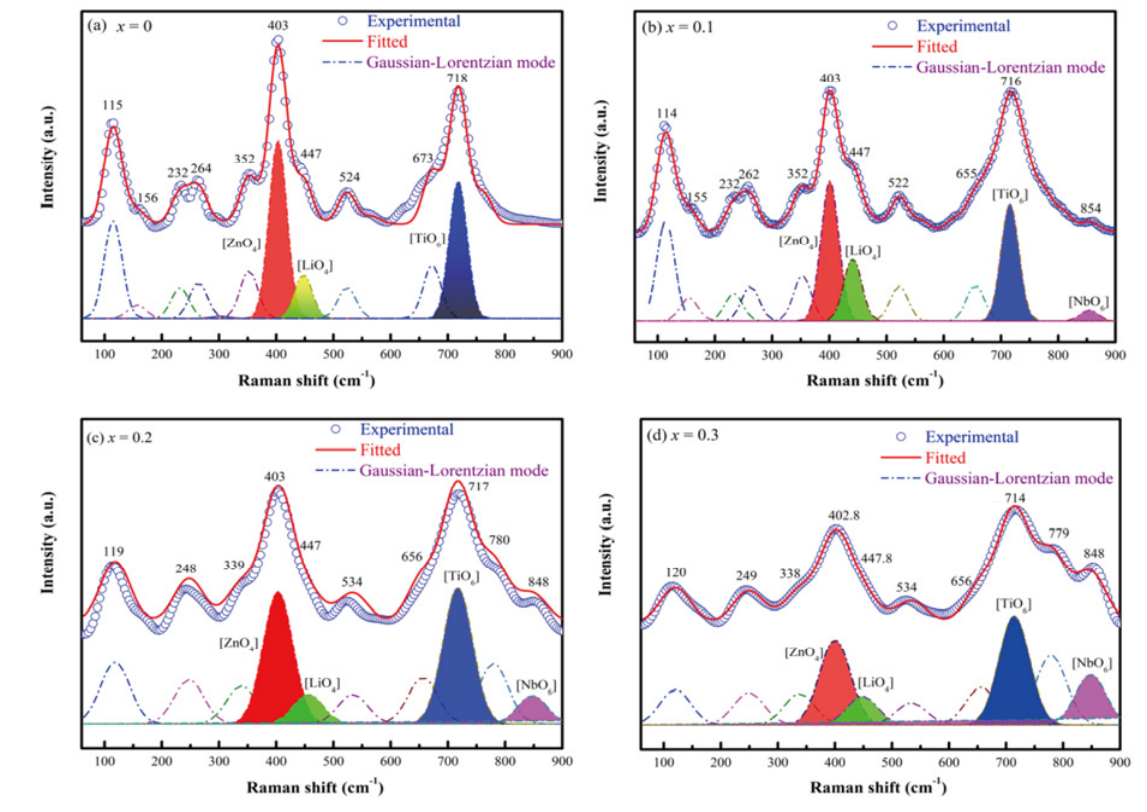
Fig. 6 Raman spectra of LZTNN x ceramics sintered at optimized temperatures fitted by Gaussian–Lorentzian function: (a) x = 0, (b) x = 0.1, (c) x = 0.2, and (d) x =